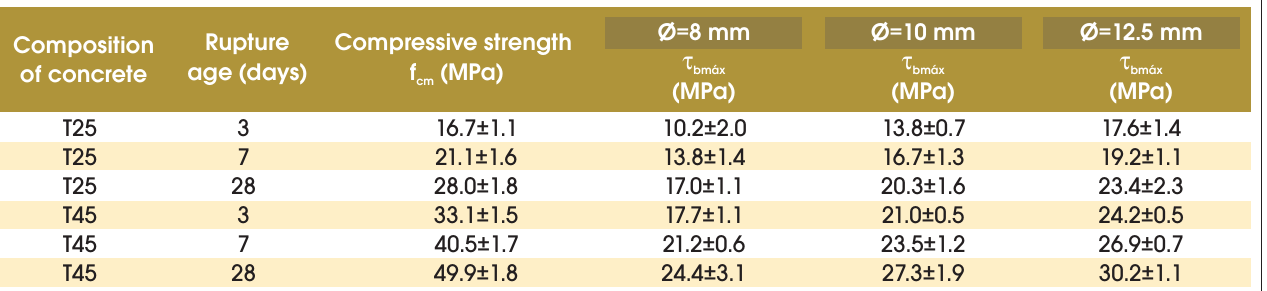
Table 4 – Average values of maximum bond strength obtained in the bond tests (POT) and average values of compressive strength of the concrete